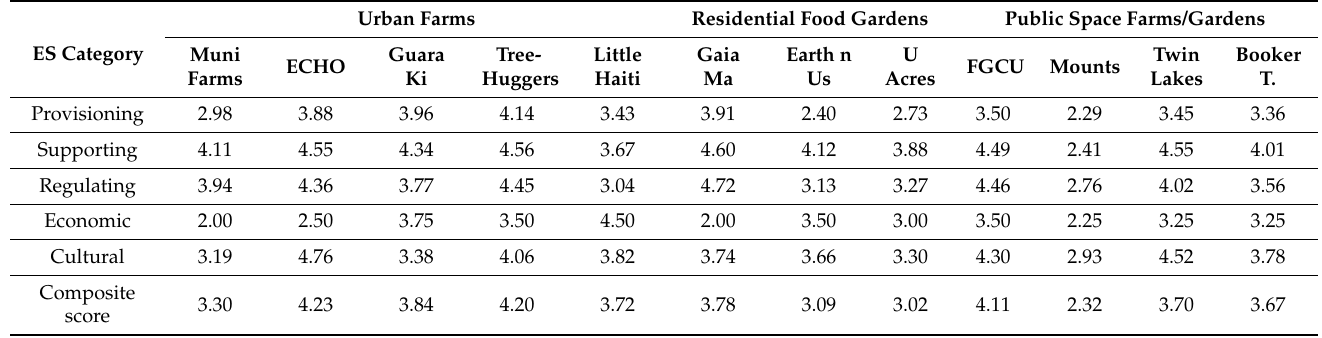
Table 4. Ecosystem services ranking of representative agro-ecological systems based on